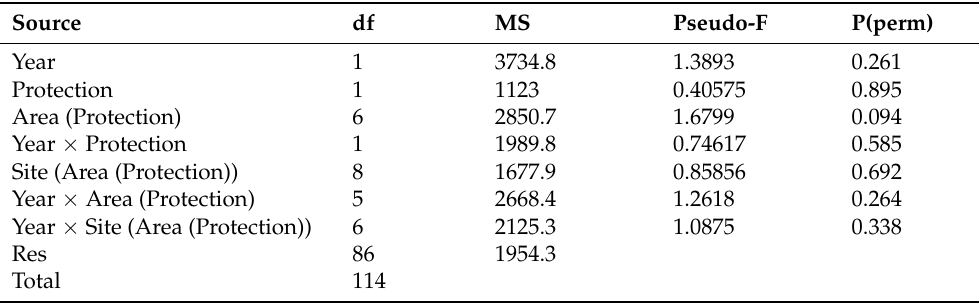
Note: df—degrees of freedom; MS—mean squares; Pseudo-F—pseudo-F ratio; P(perm)— p -value based on permutations.